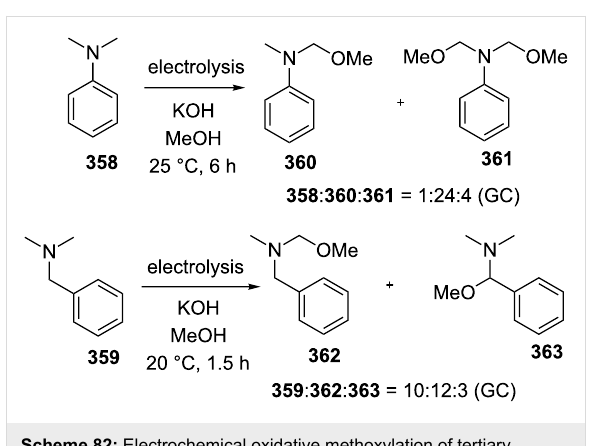
Scheme 82: Electrochemical oxidative methoxylation of tertiary amines.